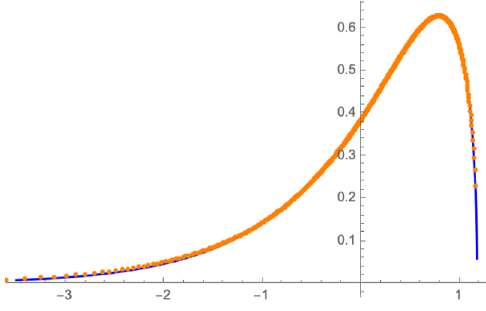
Figure 6 . Eigenvalue density for SU( N/ 2) dots are the numerical result while the blue curve is a fit to the function a fit at a = 0 . 3566 , b = 1 . 182 and c = 1 . 308